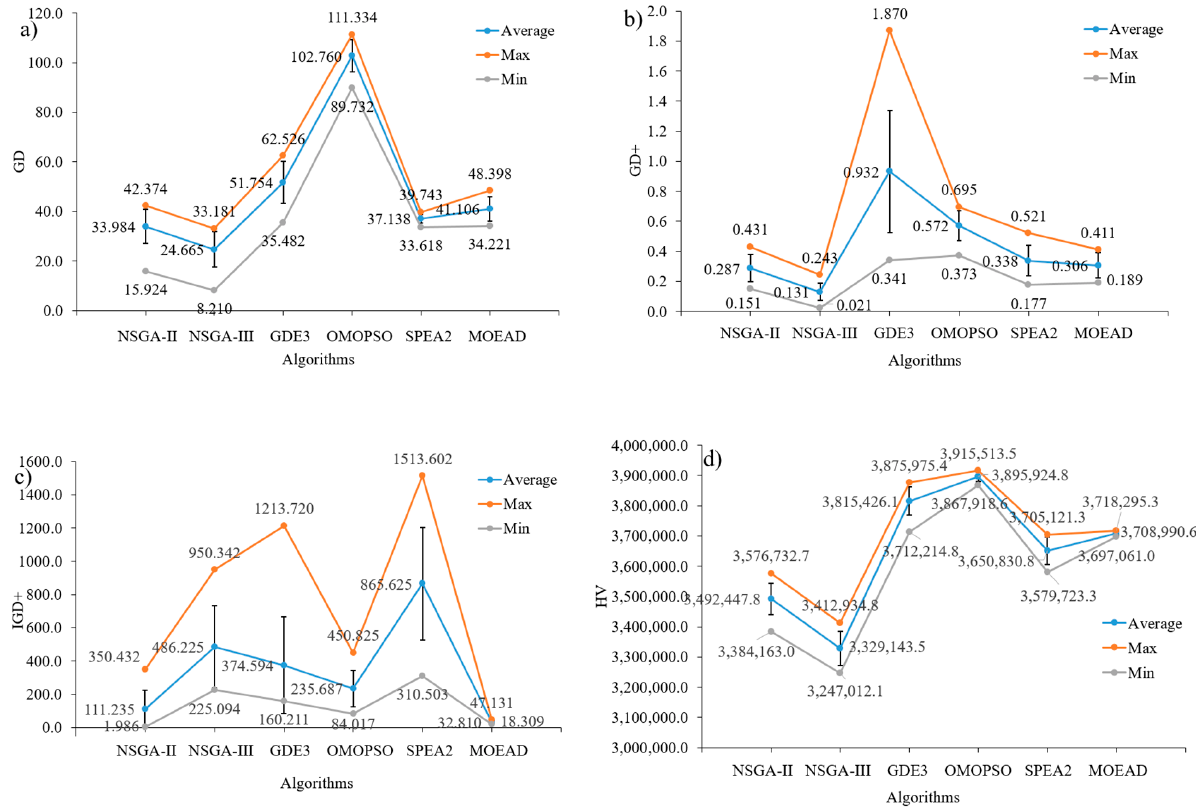
Figure 20. GD, GD+, IGD+, and HV of the MOO algorithms of the 113-bar truss bridge: ( a ) GD; ( b ) GD+; ( c ) IGD+; ( d ) HV.